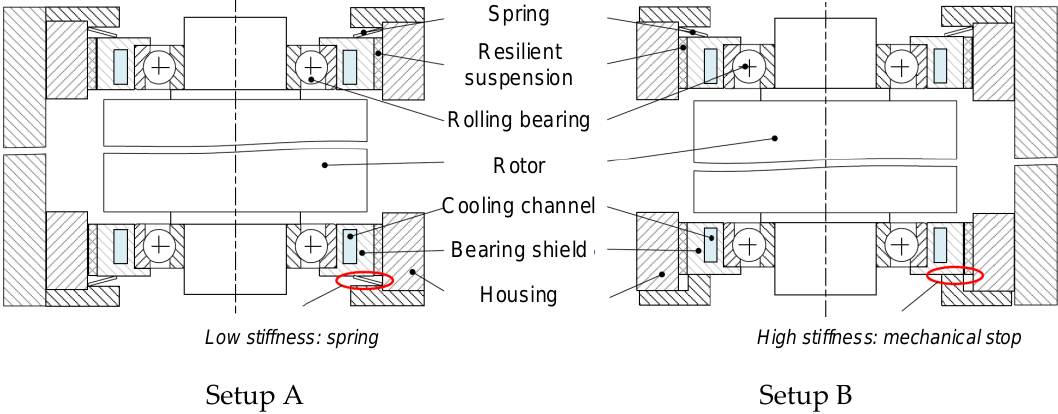
Figure 13. Two concepts regarding axial spring preload of bearings in X-arrangement.